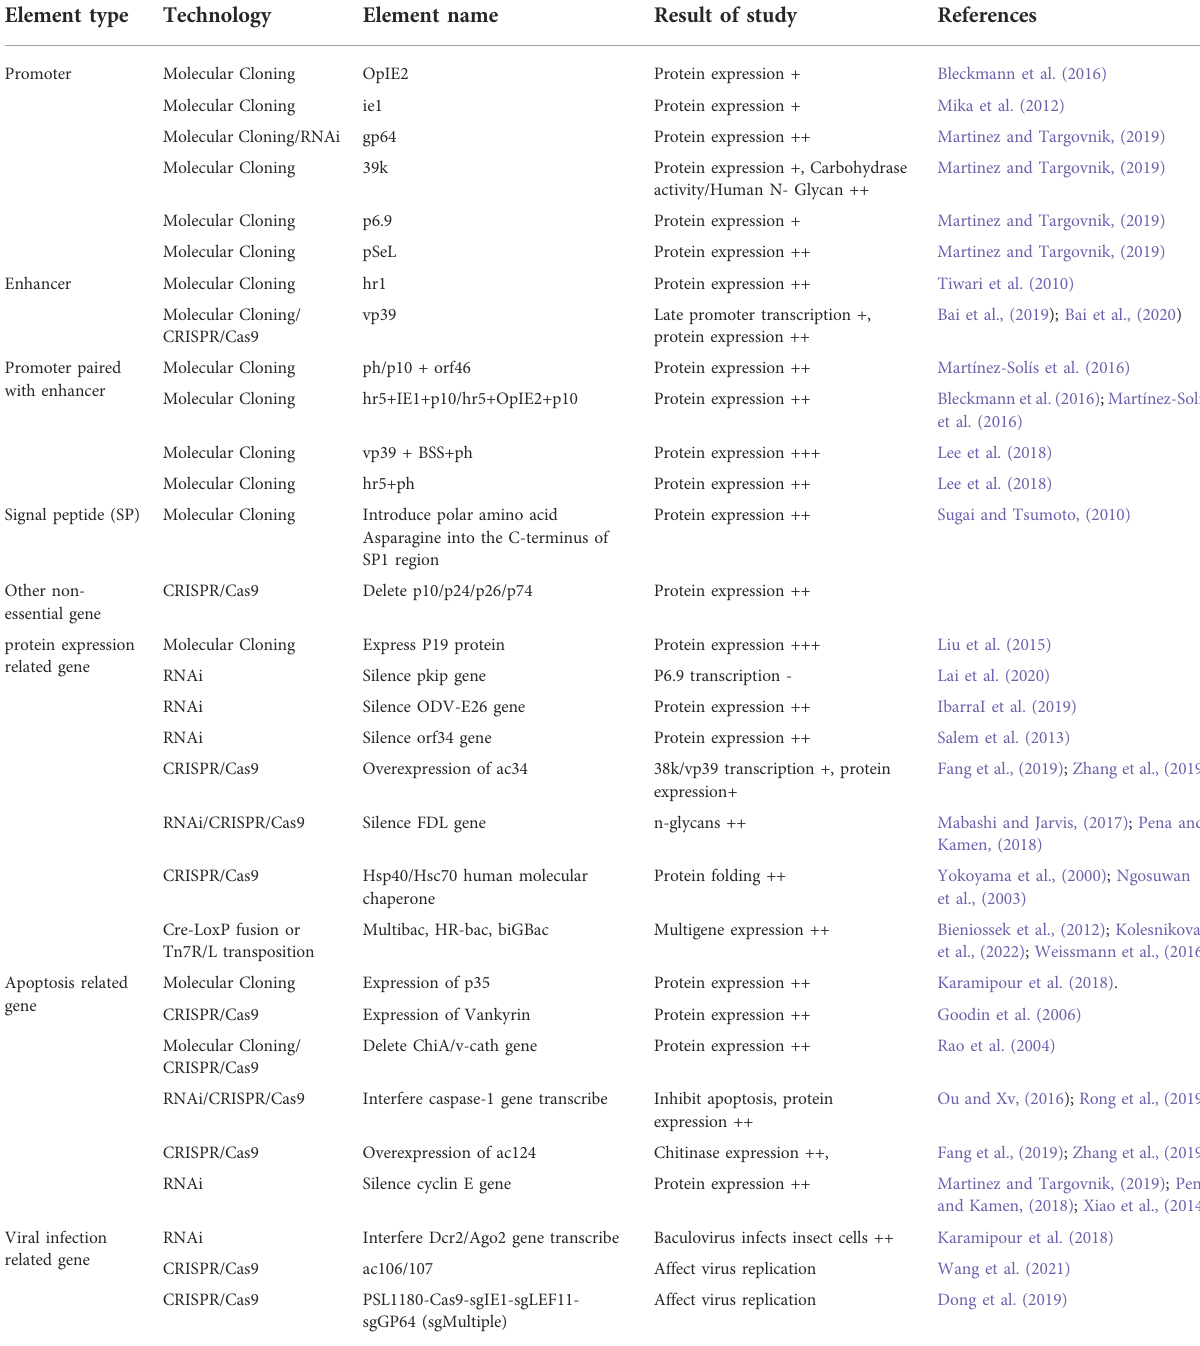
TABLE 2 A summary of function studies related to BEVS presented in this